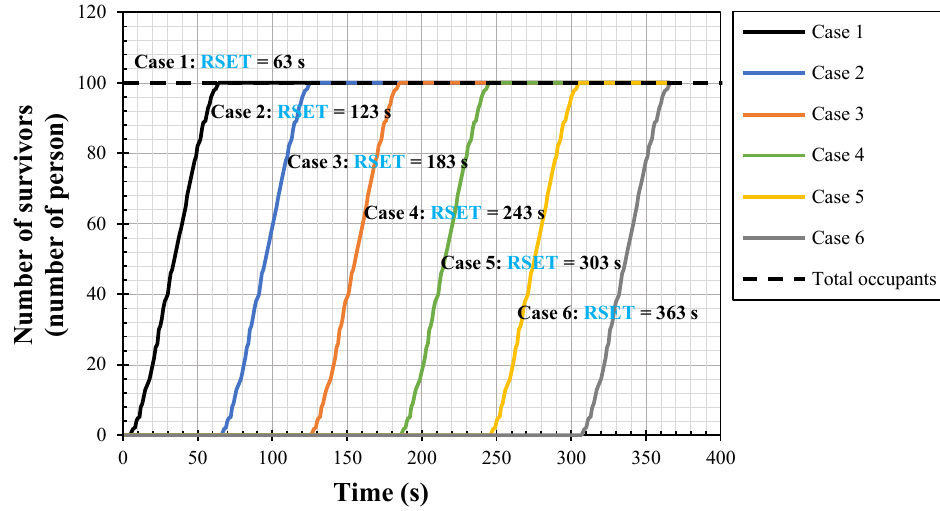
Figure 9. Analysis results (number of survivors).